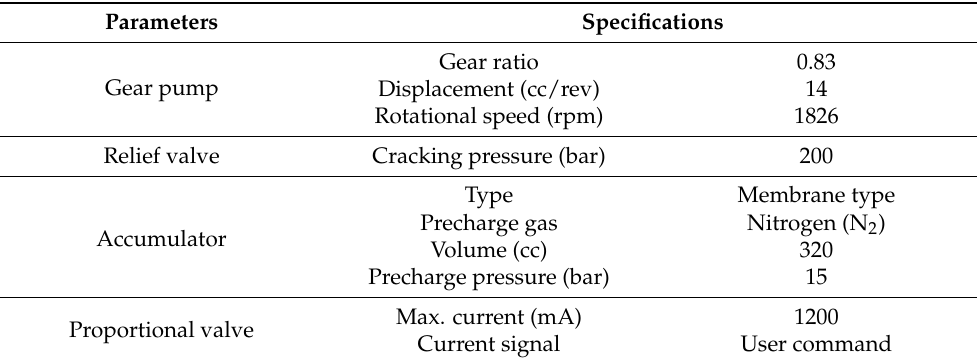
Table 2. The hydraulic component specifications of the simulation